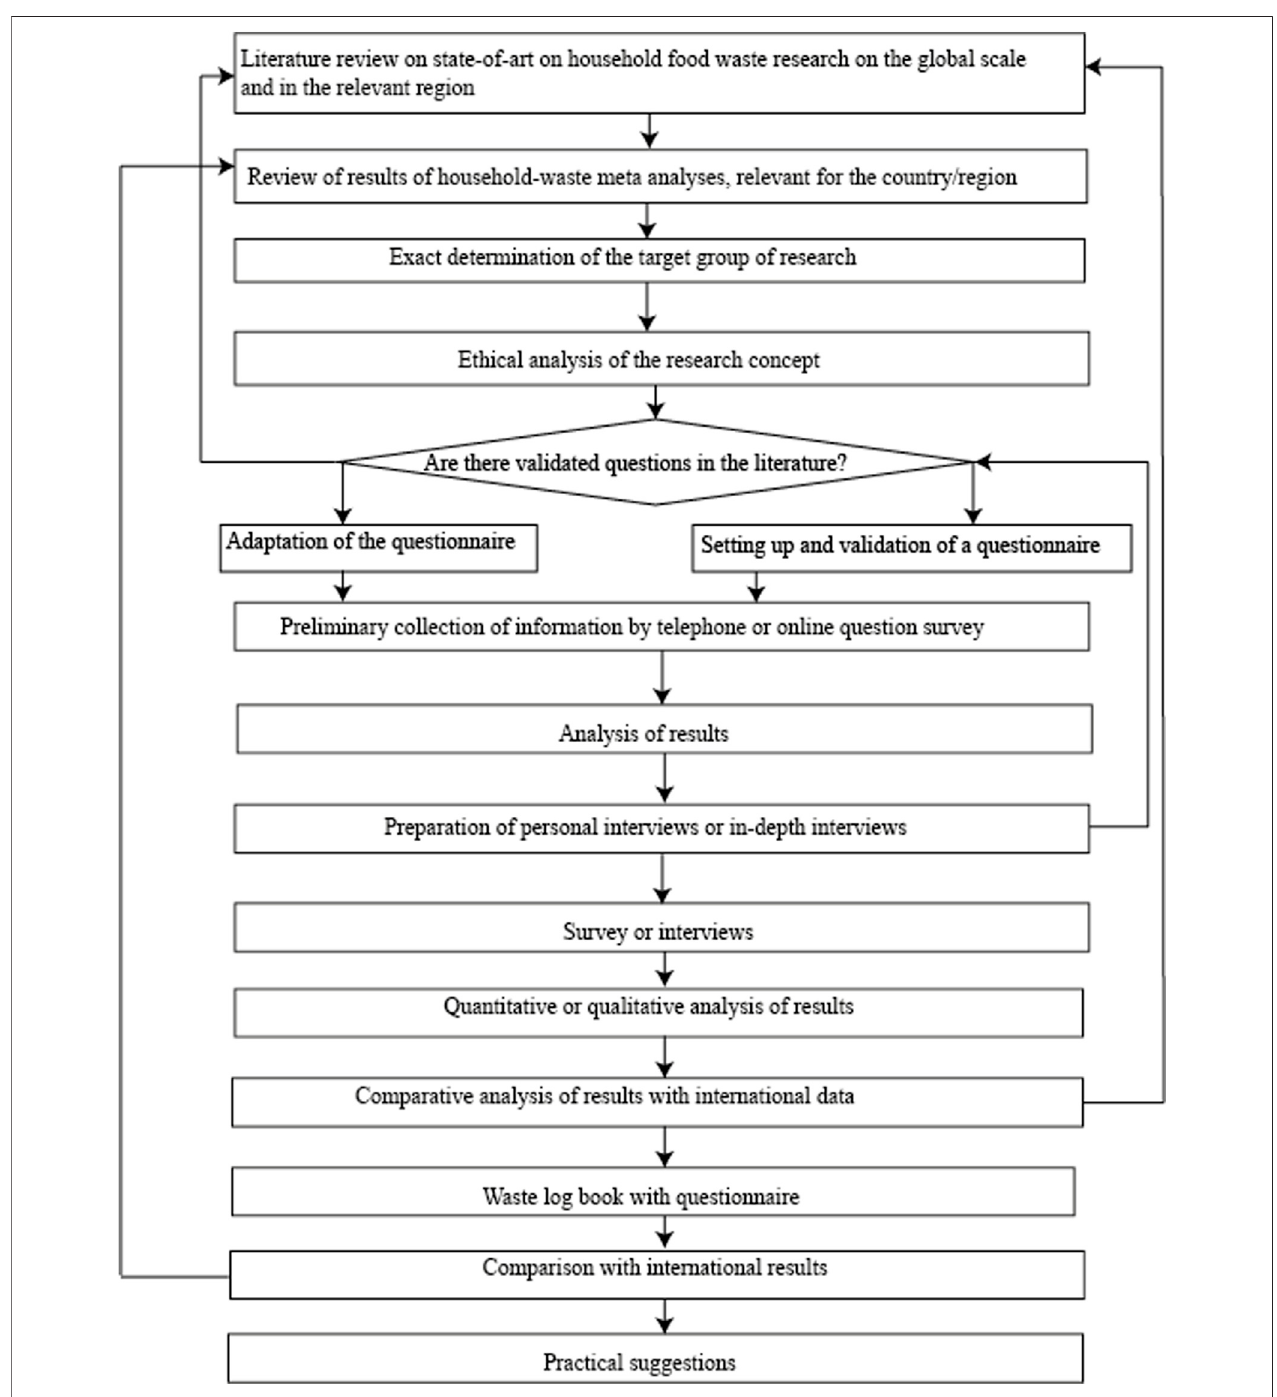
FIGURE 10 | Work fl ow of an in-depth food waste research project.